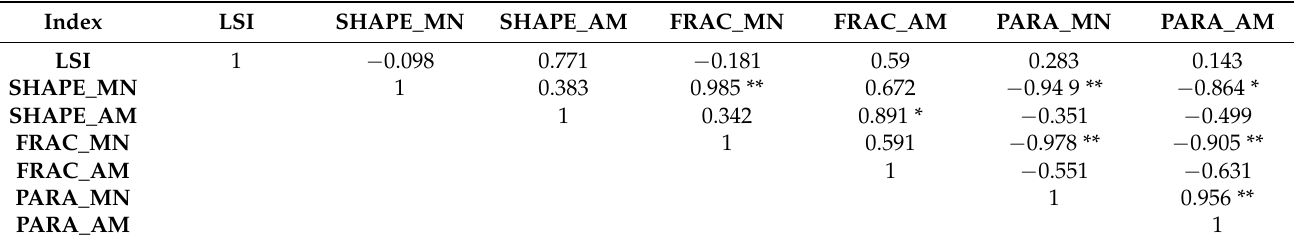
Table A4. Pearson’s Correlation Coefficients of the Shape Metrics.